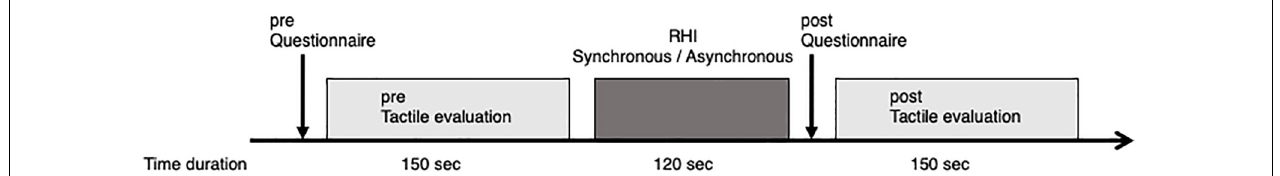
FIGURE 1 | Schematic representation of the series of experimental operations. The experiment was conducted based on the A–B or B–A experimental design, composed of synchronous and asynchronous conditions. Each condition was composed of a series of operations consisting of a questionnaire, tactile evaluation, and RHI. The baseline (denoted as pre) of illusion rating questionnaires and tactile evaluation was performed prior to the start of the 120 s of visuo-tactile stimulation. Immediately following the visuo-tactile stimulation, illusion rating questionnaires and tactile evaluation was performed again (denoted as post).